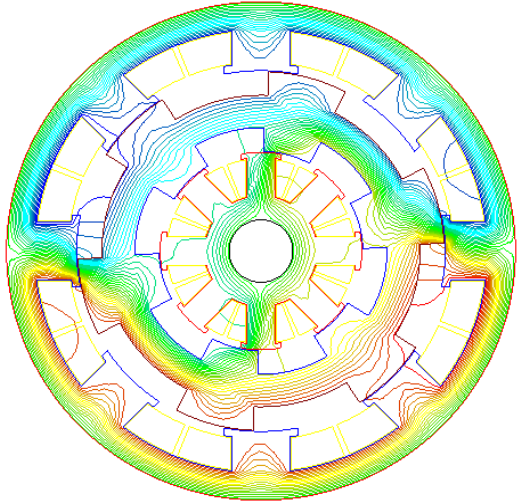
Figure 17. Flux distribution of the SRDRM when the inner rotor rotates clockwise relative to the outer